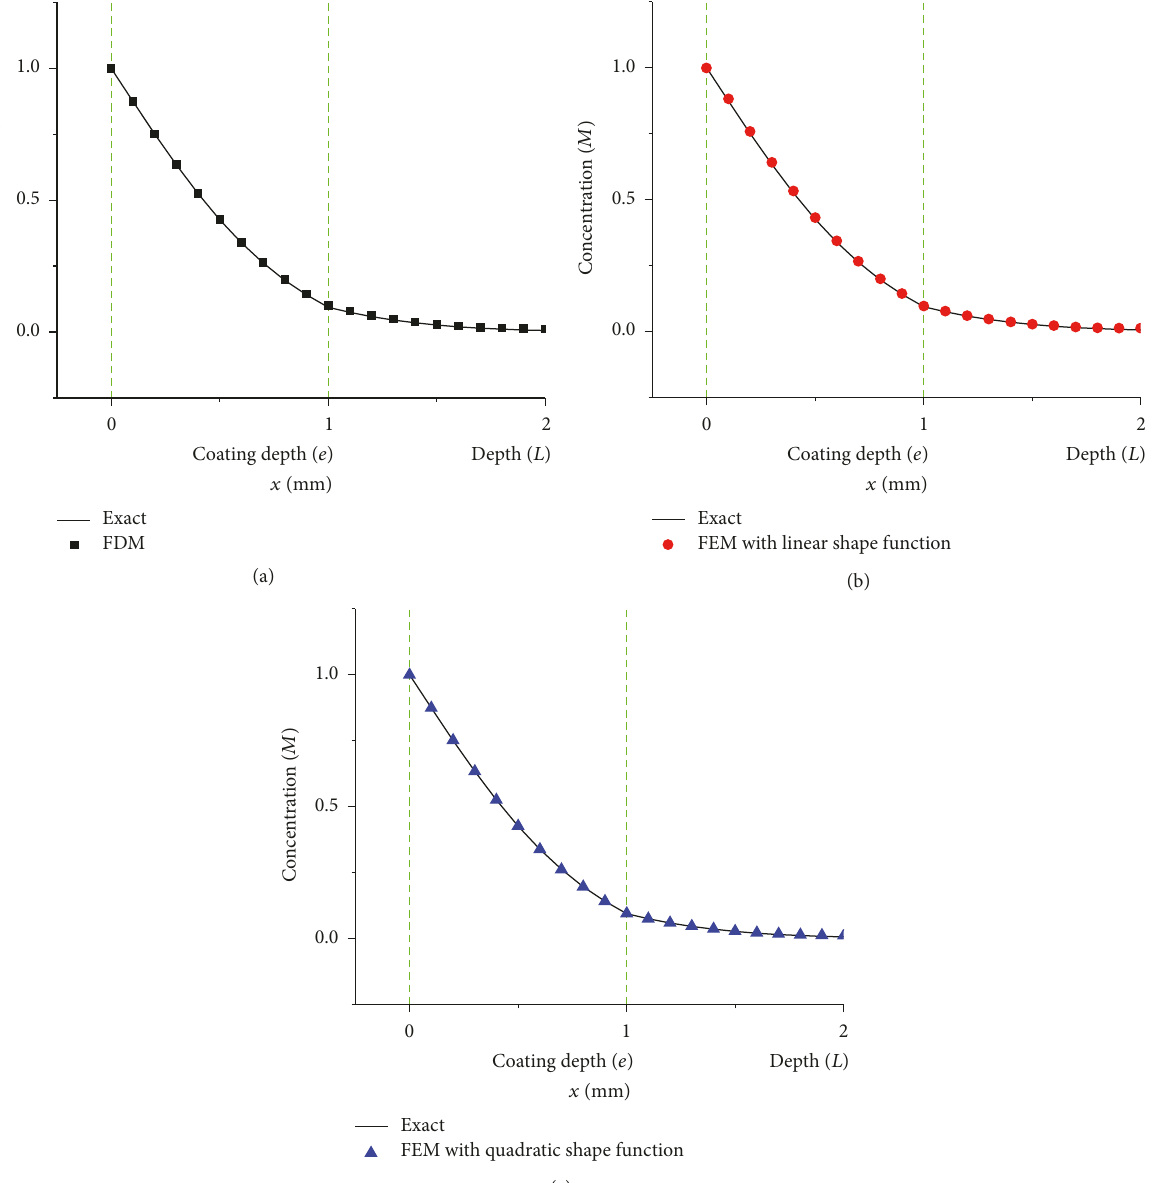
/𝐷 of 𝐷 means that surface coatings acting as a concrete coating barrier are 10, 5, and 2 times more effective than concrete in preventing the penetration of ions. Hence, 𝐷 of 10, 5, and 2, respectively, represent large, moderate, and small differences in diffusivities of coatings and